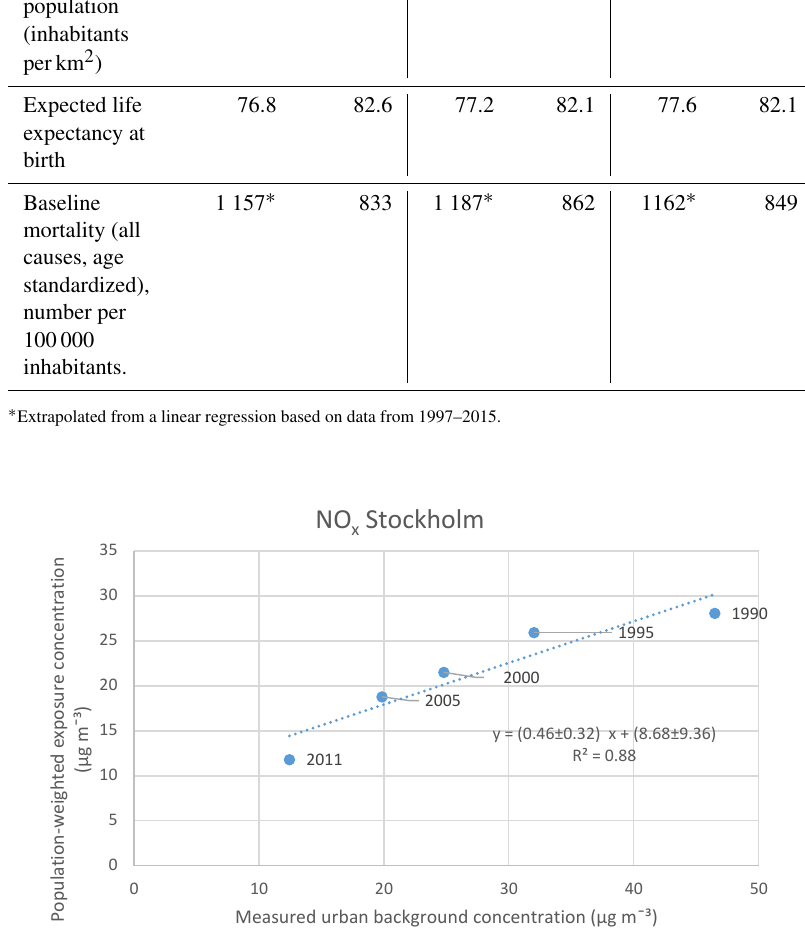
Figure A1. Relationship between measured urban background concentrations and population-weighted exposure concentrations of NO x in Stockholm. Slope and intercept are specified with 95% confidence